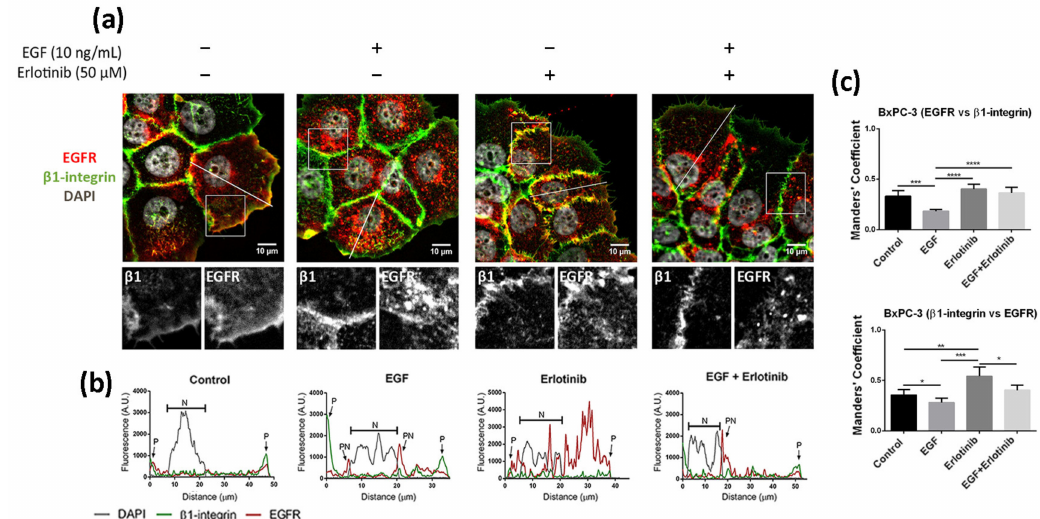
Figure 4. Immunofluorescence analysis of the EGFR in BxPC-3 cells incubated with EGF, erlotinib or both in 2D cultures. ( a ) EGFR (red) and β 1-integrin (green) immunofluorescence counterstained with DAPI (grey) in the presence of EGF, erlotinib or both and close-up sections (gray pictures). Scale bars represent 10 µ m; ( b ) fluorescence intensity profiles corresponding to the white line in pictures from ( a ). Different cell regions are indicated as: P for cell periphery, N for nucleus and PN for perinuclear area; ( c ) Manders’ colocalization coefficients. Statistical differences are indicated as * for p < 0.05, ** for p < 0.01, *** for p < 0.001 and **** for p <